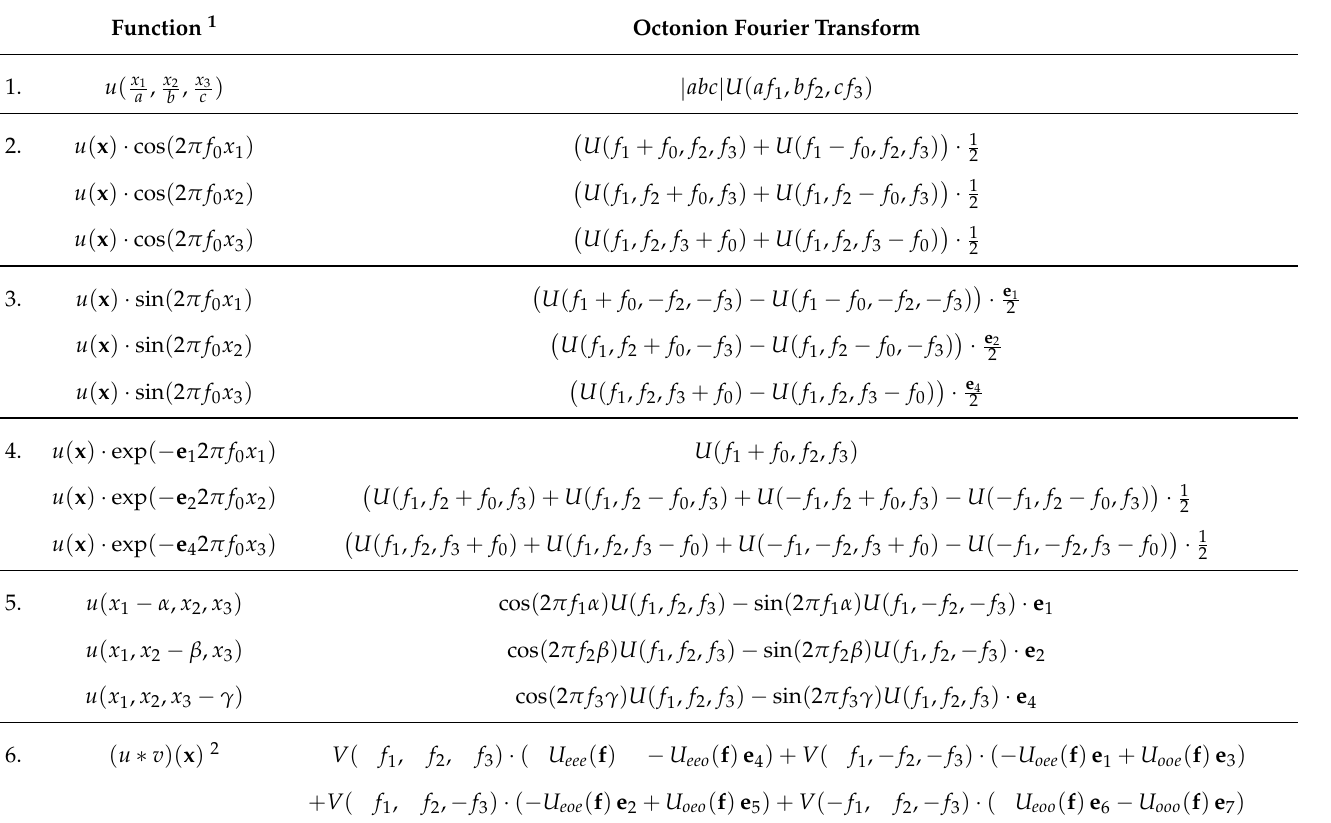
Table 1. Summary of Octonion Fourier Transform